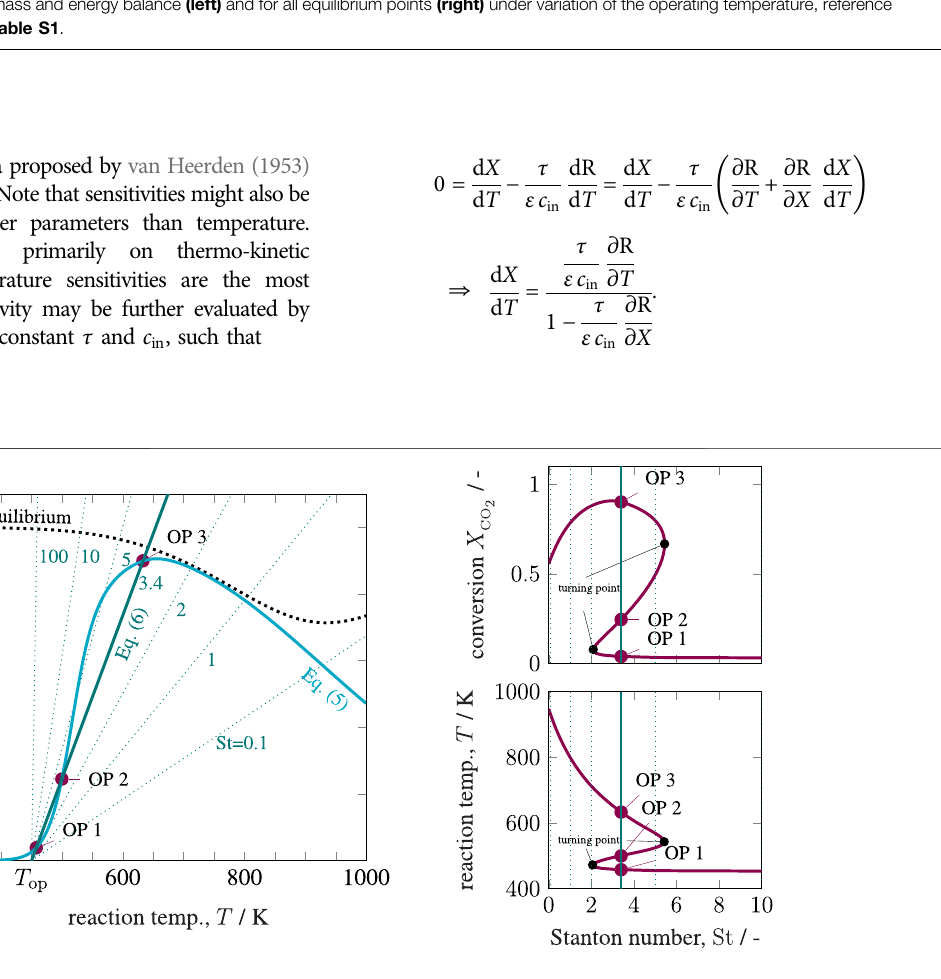
FIGURE 5 | State-space diagram for mass and energy balance (left) and for all equilibrium points (right) under variation of the Stanton number, reference setting taken from Supplementary Table S1 .